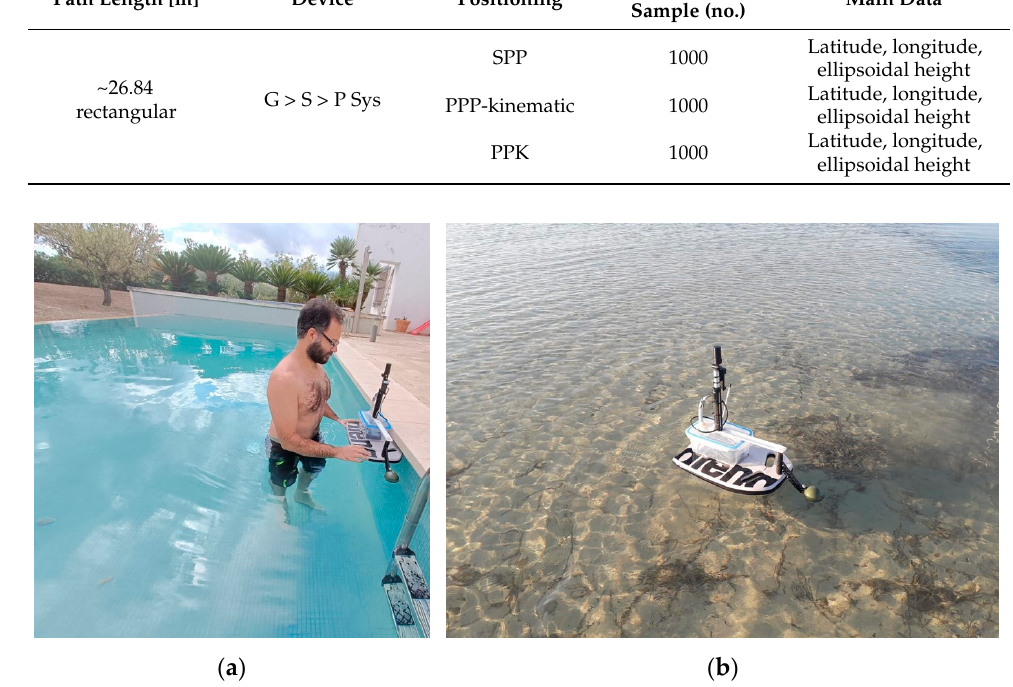
Figure 2. ( a ) Pool test; ( b ) instrumentation mounted on the floating platform.